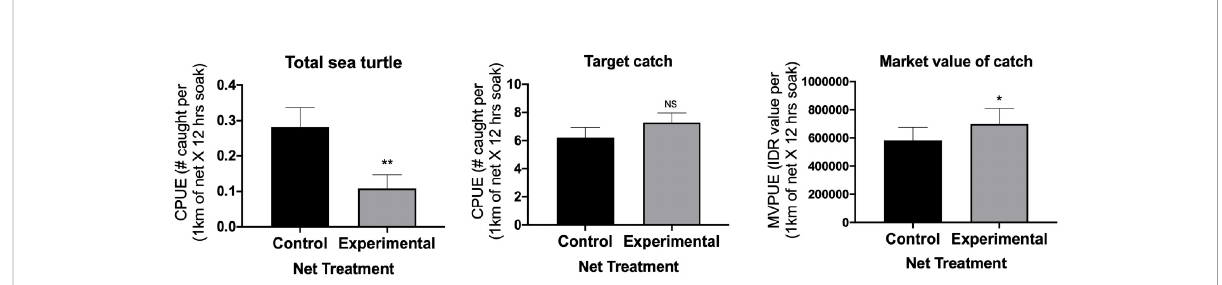
FIGURE 2 Comparison of total sea turtle mean CPUE [catch per unit effort = number caught/(1km of net X 12 hrs soak time)], mean target catch ( Parastromateus niger, Pampus argenteus, and Pampus chinensis ), and mean MVPUE (market value per unit effort) of the total catch between control nets and illuminated nets. Error bars are standard error (SE), NS, not signi fi cant, ** indicates p < 0.01, * indicates p <